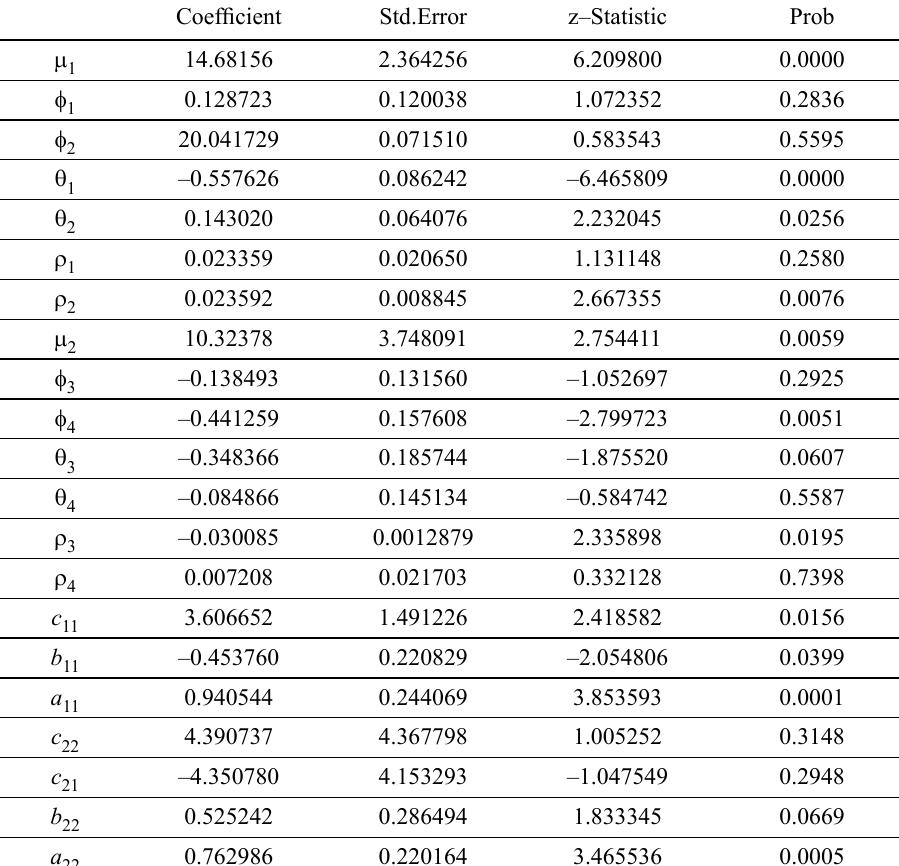
Table 2. Estimated parameters of bivariate BEKK